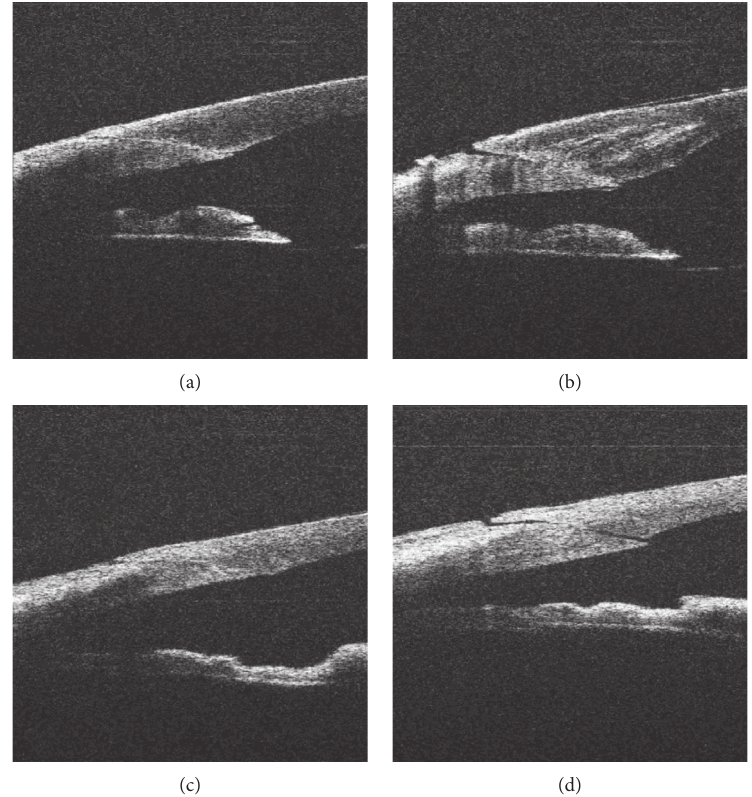
Figure 7: Worsening of corneal incision morphology after its hydration. Well-adapted corneal incision before hydration (a); gap de- velopment in the corneal incision periphery after lateral stromal hydration (b). Well-adapted corneal incision before hydration (c); corneal incision almost opened longitudinally after lateral stromal hydration (d).